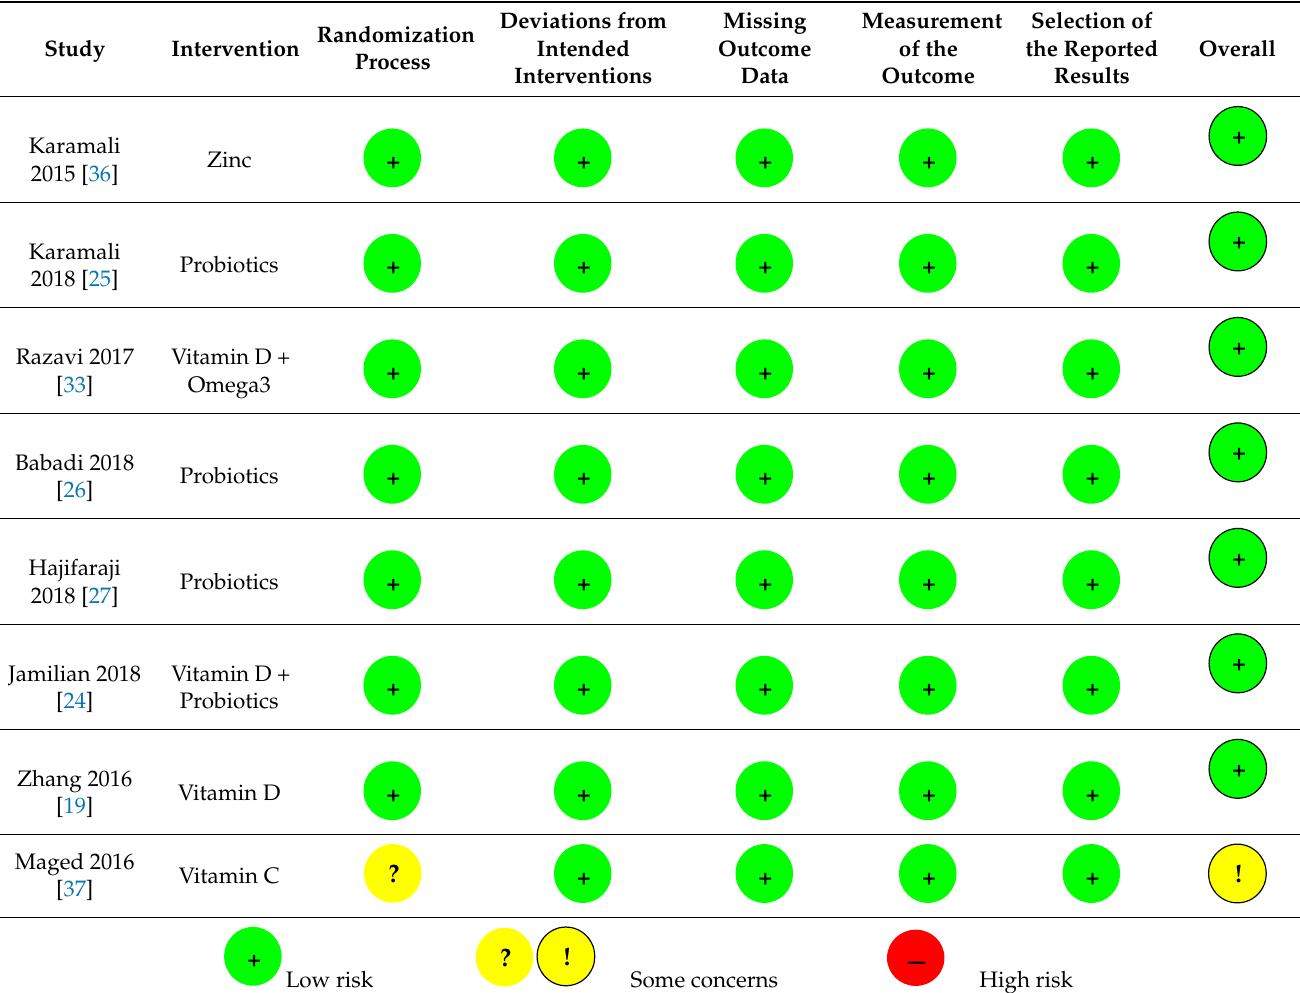
Table 2. Risk of bias of selected studies.